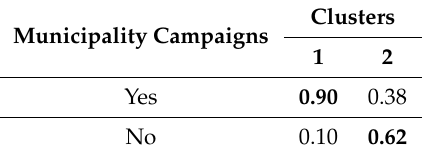
Table 6. Distribution of the categorical variable “municipality campaigns”.